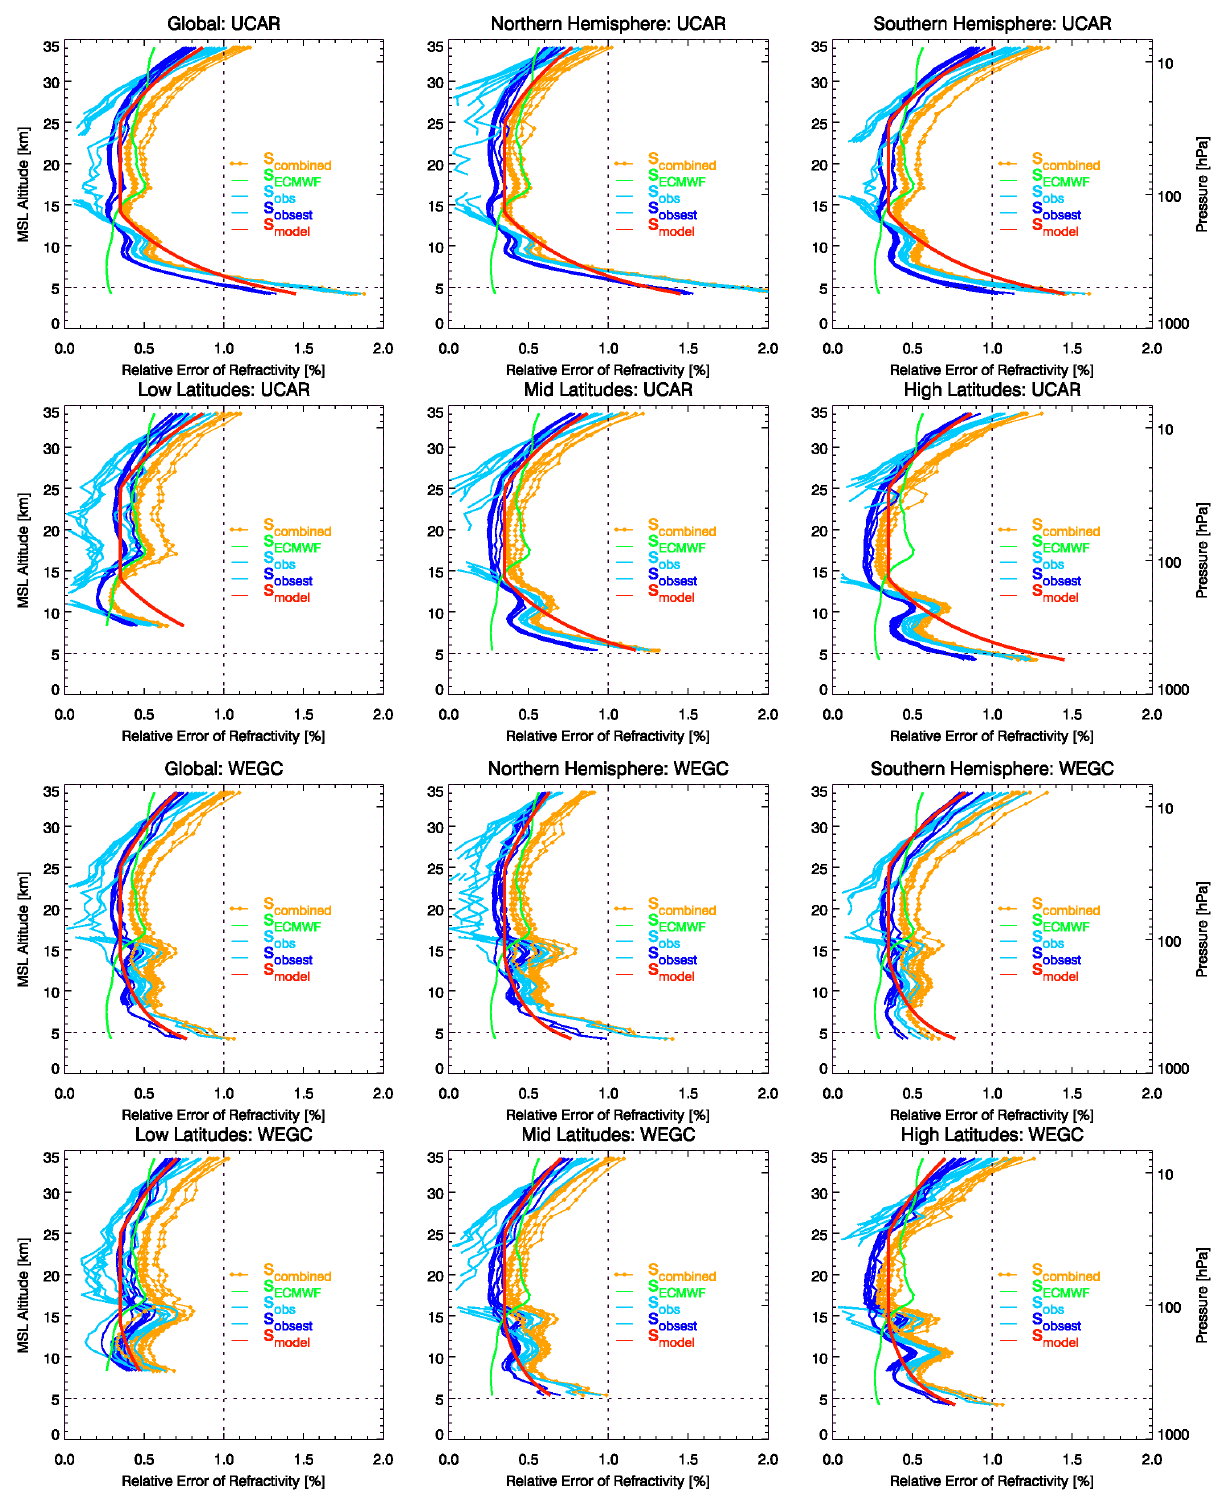
Fig. 5. RO plus ECMWF combined error (yellow), estimated ECMWF error (green), observational error (light blue), estimated observational error (dark blue), and observational error model (red) in July 2008. UCAR (top two rows) and WEGC (bottom two rows) refractivity errors are shown for different latitude regions (global, NH, SH, low, mid, and high latitudes). The estimation includes RO data from CHAMP, GRACE-A, and